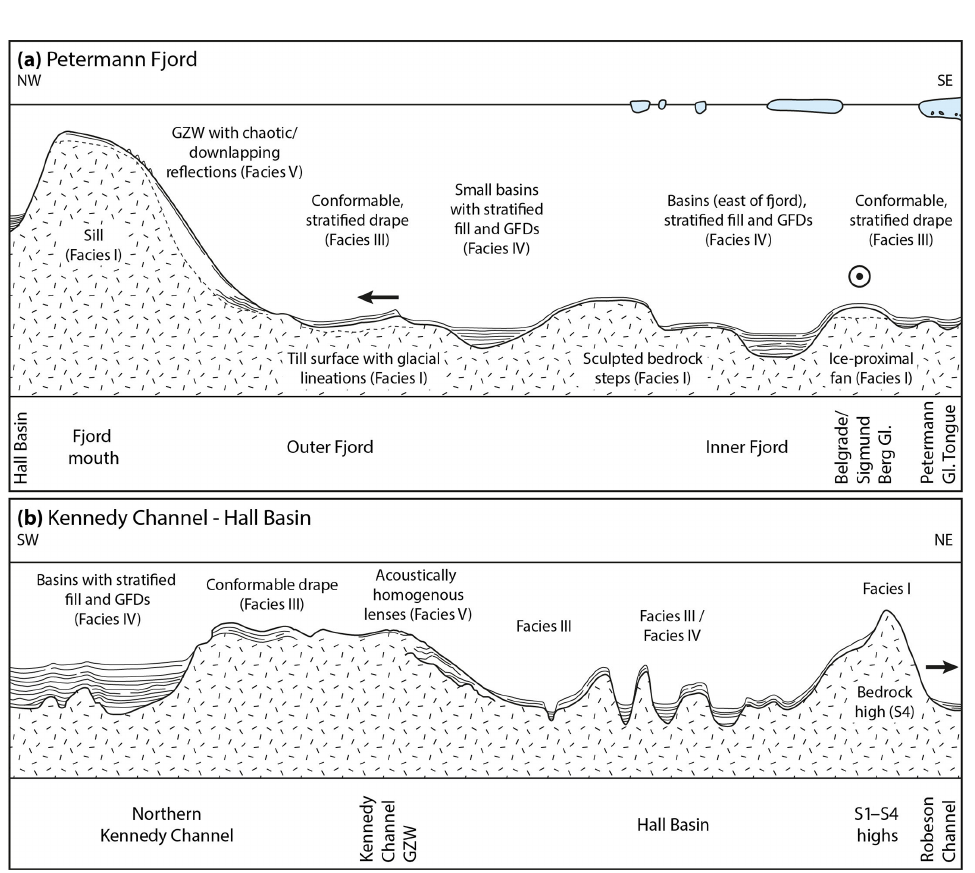
Figure 12. Conceptual transects showing the seismic stratigraphy and distribution of glacimarine sediments in the Petermann Fjord–Nares Strait area. (a) Petermann Fjord with the fjord-mouth sill with GZW on the left side; localized sediment input into the NE side of the fjord from tributary glaciers and building an ice-proximal fan is shown as the bullseye. (b) Deglacial sediment cover in Nares Strait from Kennedy Channel to Hall Basin to Robeson Channel. Not to scale. Black arrows show the former ice flow direction through the